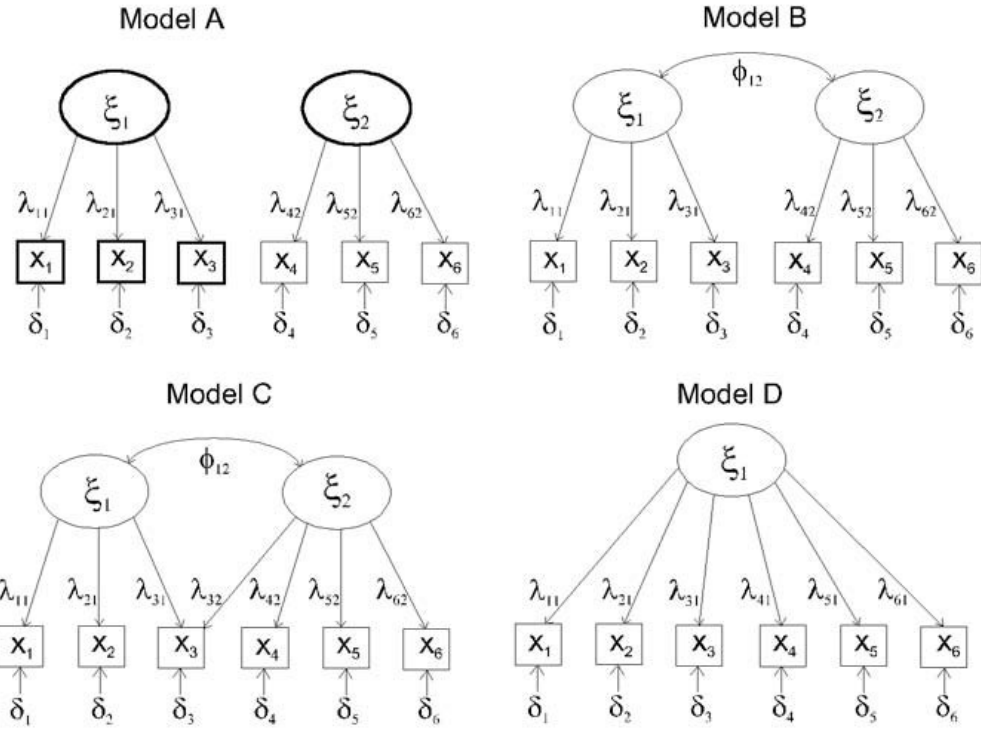
Figure 1 – Path diagram of the four